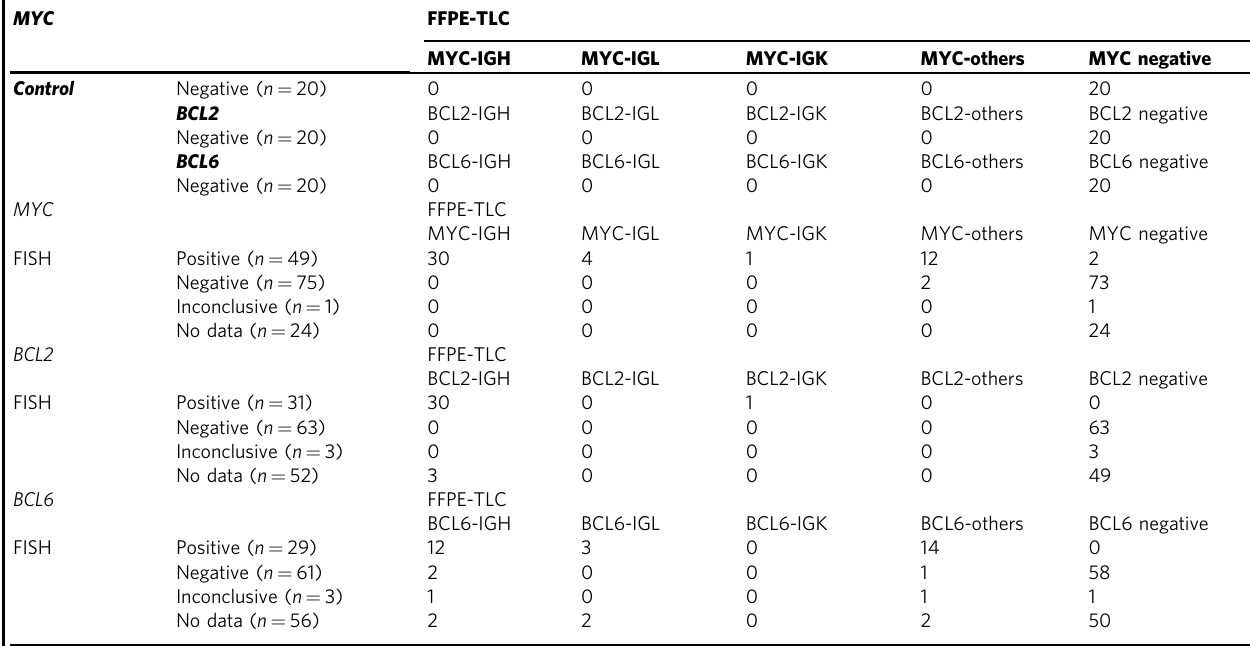
Table 1 Comparison between FISH diagnoses and FFPE-TLC